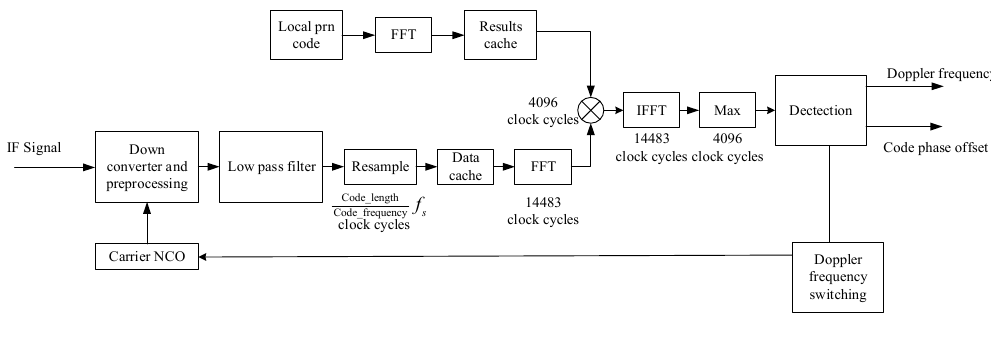
Figure 8. The acquisition process.